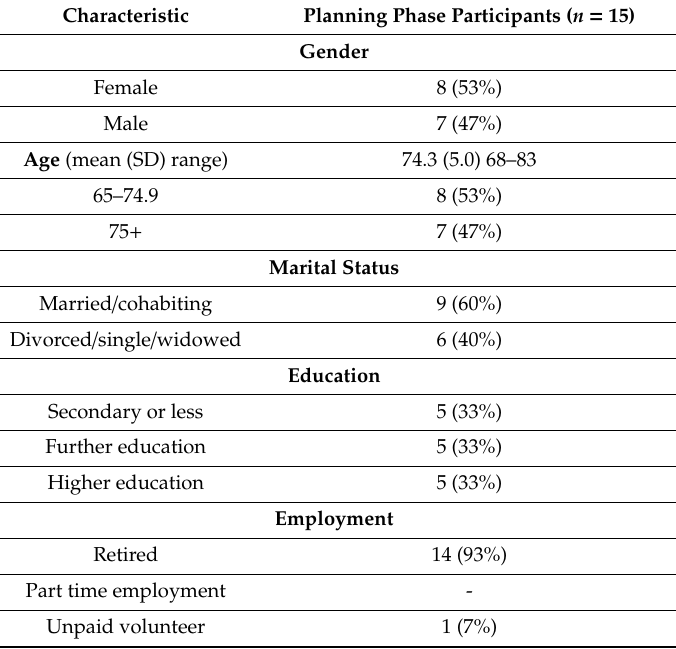
Table 1. Characteristics of participants in the planning phase.